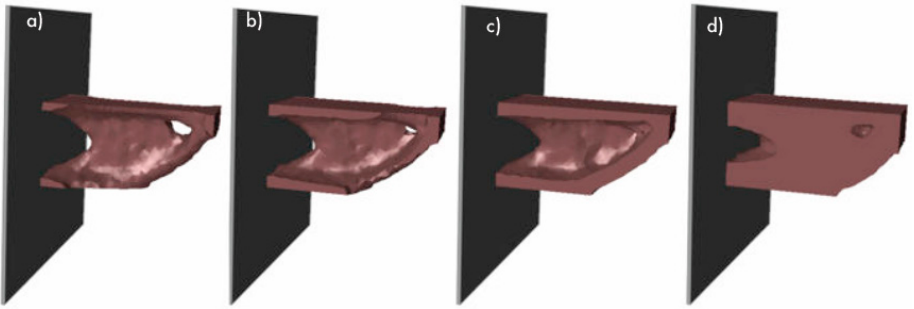
Figure 7. Fractal dimension vs. maximum displacement for different iterations of the Menger sponge.